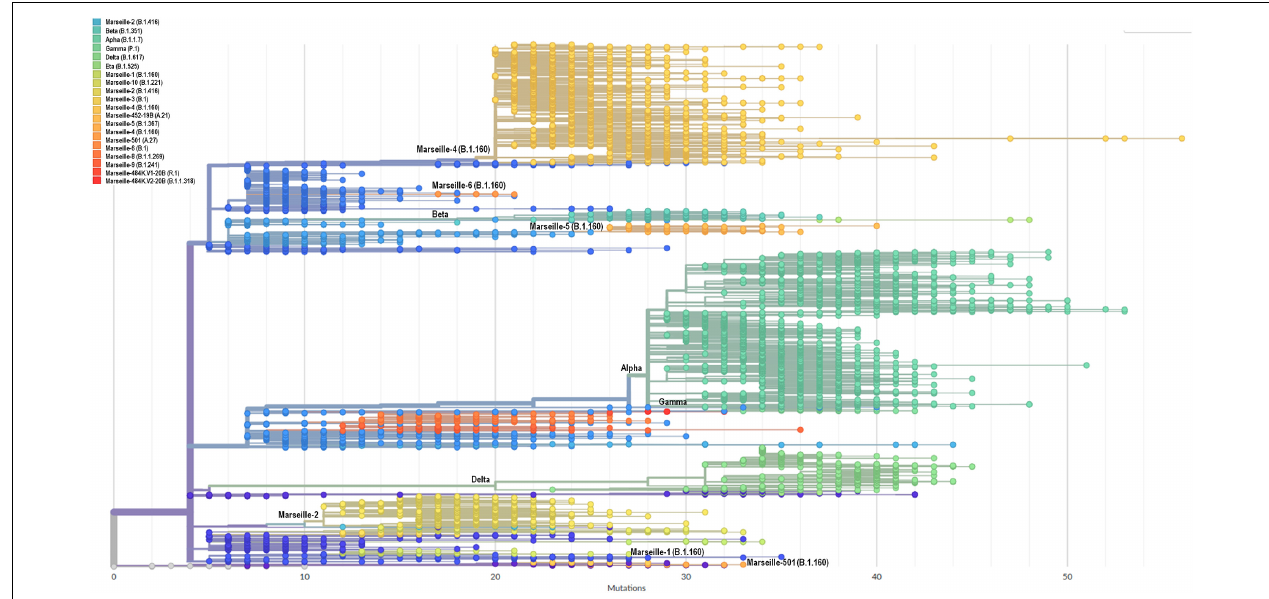
FIGURE 4 | Phylogenetic tree of 10,773 genomic sequences of SARS-CoV-2 obtained from patients SARS-CoV-2-diagnosed at IHU Méditerranée Infection, Marseille, France. Phylogeny reconstruction was performed using the nextstrain/ncov tool (https://github.com/nextstrain/ncov) then visualized with Auspice (https://docs.nextstrain.org/projects/auspice/en/stable/). The genome of the original Wuhan-Hu-1 coronavirus isolate (GenBank accession no. NC_045512.2) was added as outgroup. Major (most prevalent) variants are labeled. Marseille variants or WHO clades, and Pangolin, or Nextstrain clades are indicated. X -axis shows the number of mutations compared to the genome of the Wuhan-Hu-1 isolate (GenBank accession no. NC_045512.2).